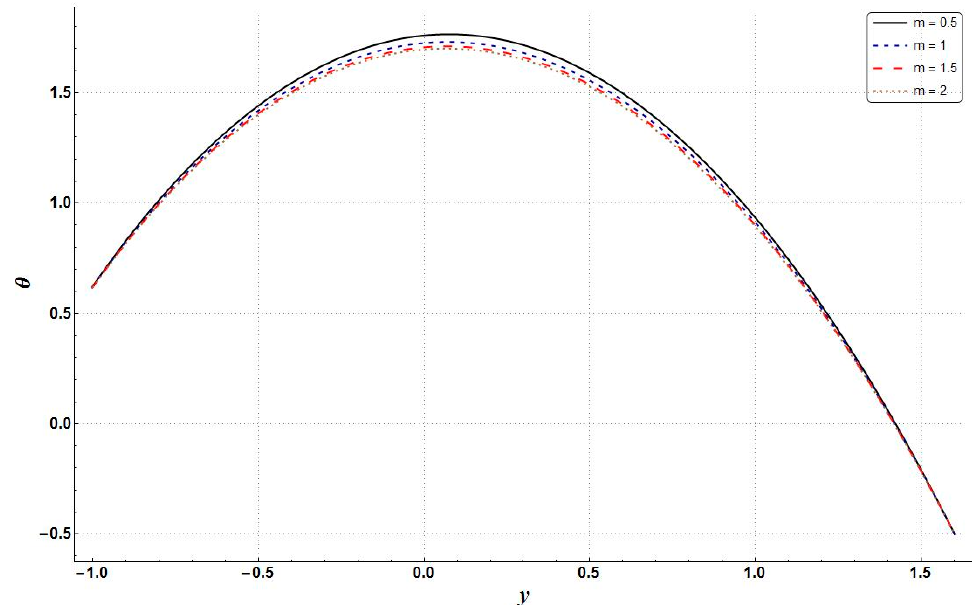
Figure 4. Influence on θ through changing values of m , where γ = π φ = 0.05, k = 2, a = 0.6, M = 1, d = 0.7, Br = 0.2, b = 0.5, ∈ = 2, η = 0.8.